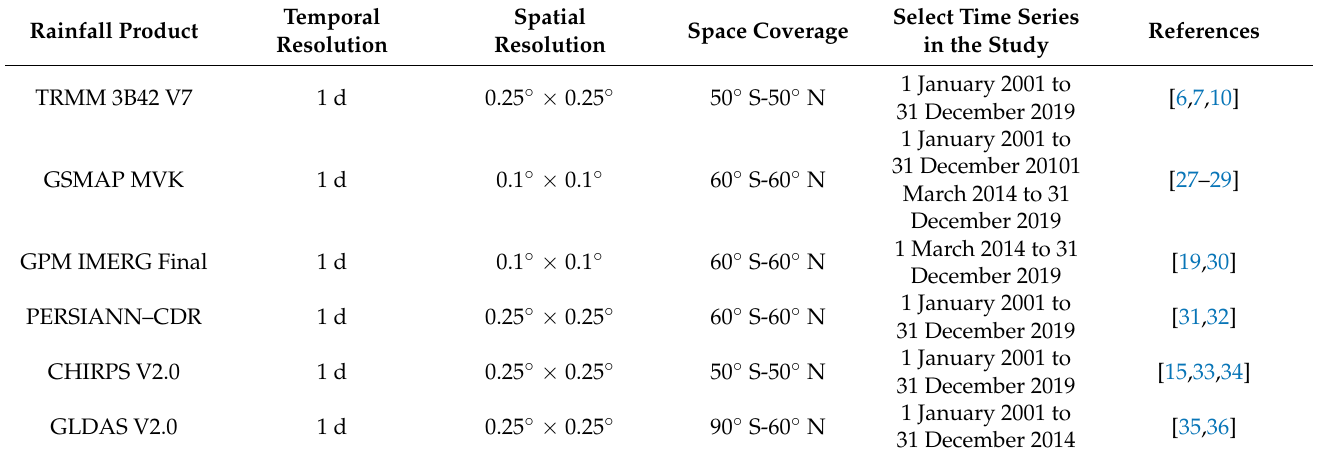
Table 3. Basic information about the six precipitation products selected in this